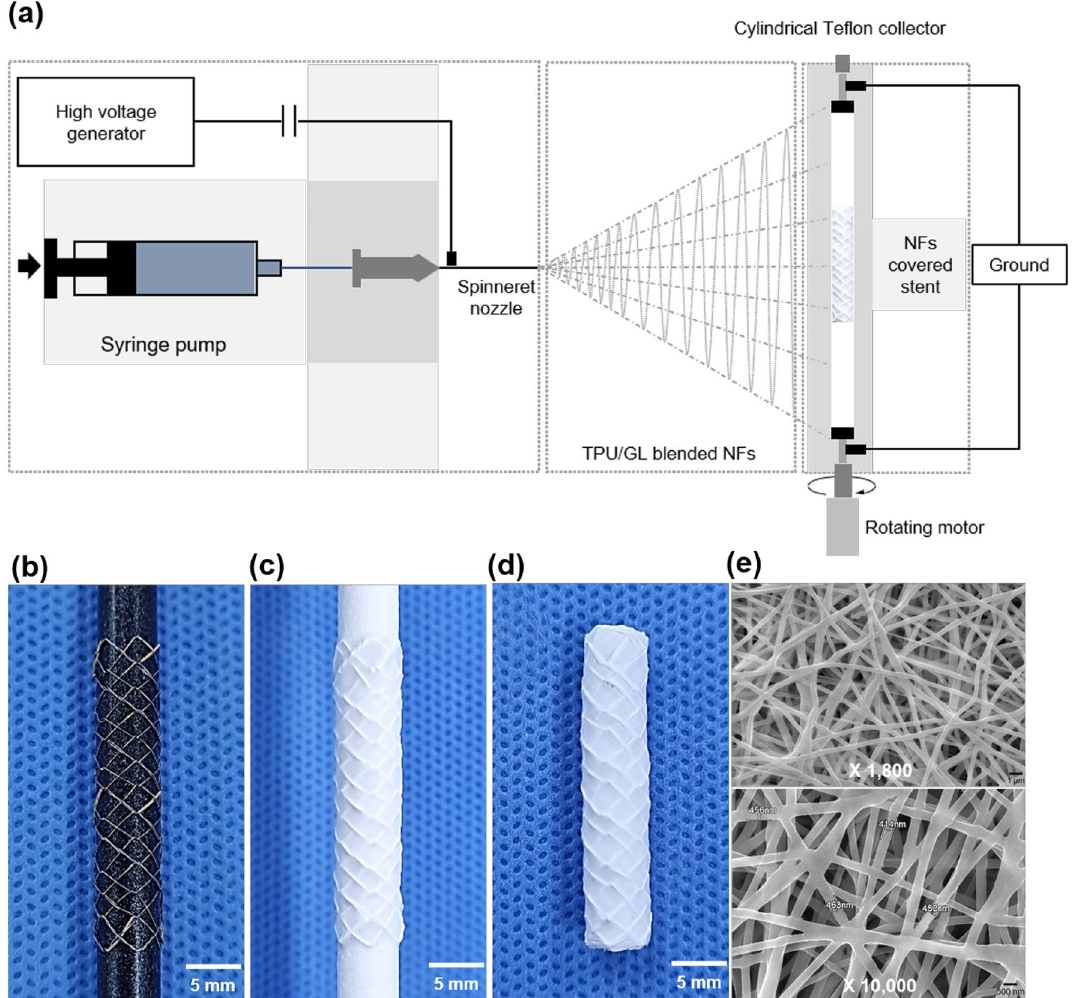
Figure 1. The technical steps of fabricated TPU and GL blended NFs-covered stent-graft using electrospinning. ( a ) Schematic image for fabrication of TPU and GL blended NFs-covered stent- graft. ( b ) The stent was secured on the cylindrical Teflon collector. ( c ) The stent with the cylindrical Teflon collector was fully coated. ( d ) TPU and GL blended NFs-covered stent-graft. ( e ) SEM images of TPU and GL blended NF scaffolds show randomly orientated NF structures at × 1,800 and × 10,000 magnification. Note. TPU: thermoplastic polyurethane, GL: gelatin, NF: